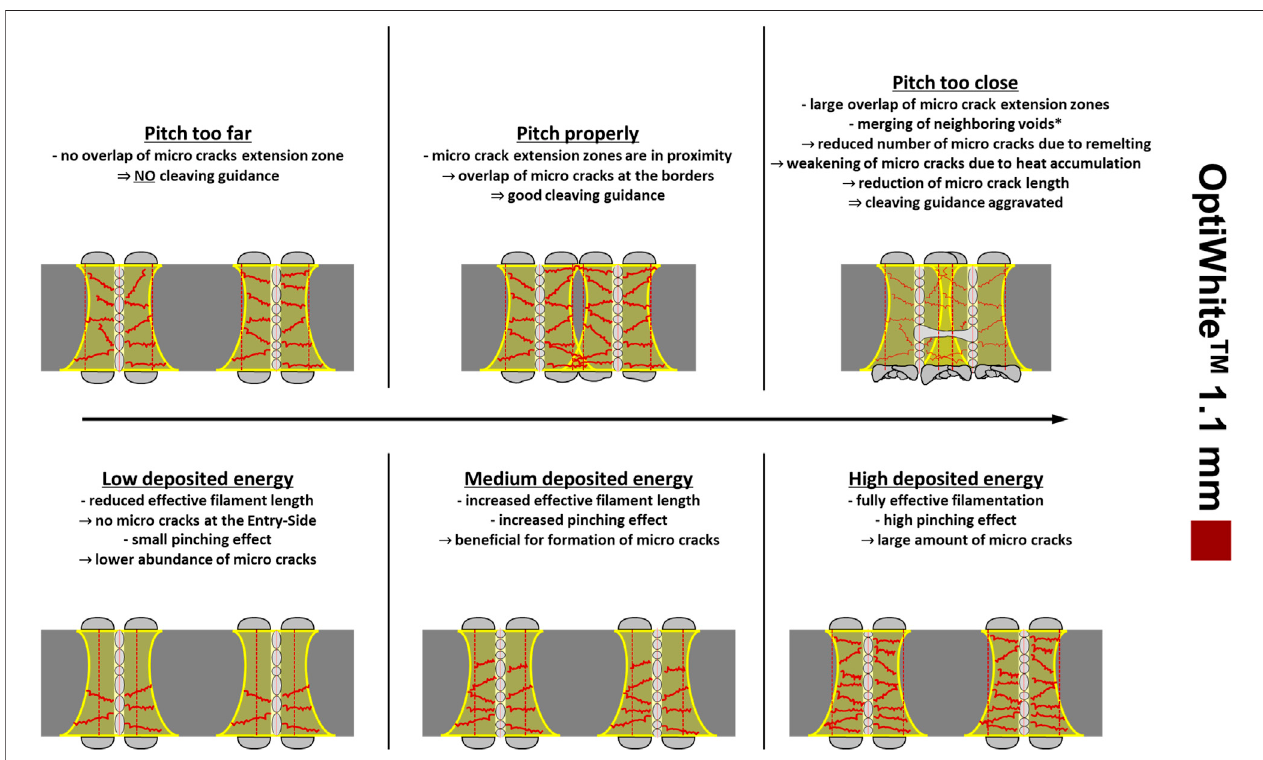
FIGURE14 | Schematic side view oftwo fi lamentstodescribe theongoings ofPitch (top) and Burst(bottom) variation for OptiWhite ™ . Thelightgray hemispheres on thetopand bottomofthesurfaces represent thesurfacemodi fi cations(see Figure2 ).Theyellow pro fi lescorrespondtothemaximum crackextension zone affected by micro cracks (red cracks) which is deduced from the roughness pro fi les (see Figure 7 ). The vertical dashed red lines indicate the laser-affected zone as seen in Figure9 .Thevoidchannelcontainsseveralvoidsduetothepinchingeffect.Atthetoprow,entireeffective fi lamentsreachthroughthethickness.Witha “ Pitchtoo far ” nointeractionbetweenadjacent fi lamentsisvisibleandthemicrocracksareonlyformedwithinthemaximummicrocrackextensionzone(yellow).At “ Pitchproperly ” the fi laments approach each other, and micro cracks might connect where an overlap of the micro crack extension zones is present. For “ Pitch too close ” a very large overlapofthemicrocrackextensionzonesispresentandaweakeningofthemicrocracksisexpectedaswellaslarge,interconnectingvoidsareformedduetocon fi ned heat accumulation. At the bottom row, “ Low deposited Energy ” caused a reduced effective fi lament with stretched voids and micro cracks only form at the Focus Side. “ Medium deposited Energy ” increased the effective fi lament length, a larger fraction of the material is generating micro cracks and a higher abundance of singular voids due toahigher pinchingeffect isexpected. With “ High deposited Energy ” athorough effective fi lament isformed with alargevariationofthevoid morphology.Thelaser- affected zone (red dashed vertical lines) changes gradually with increasing energy. *merging of voids is expected to be a combination of too close fi laments generated with exceeding deposited energy. For more detailed explanation consider the description within the fi gure and Section 4.9.1 .